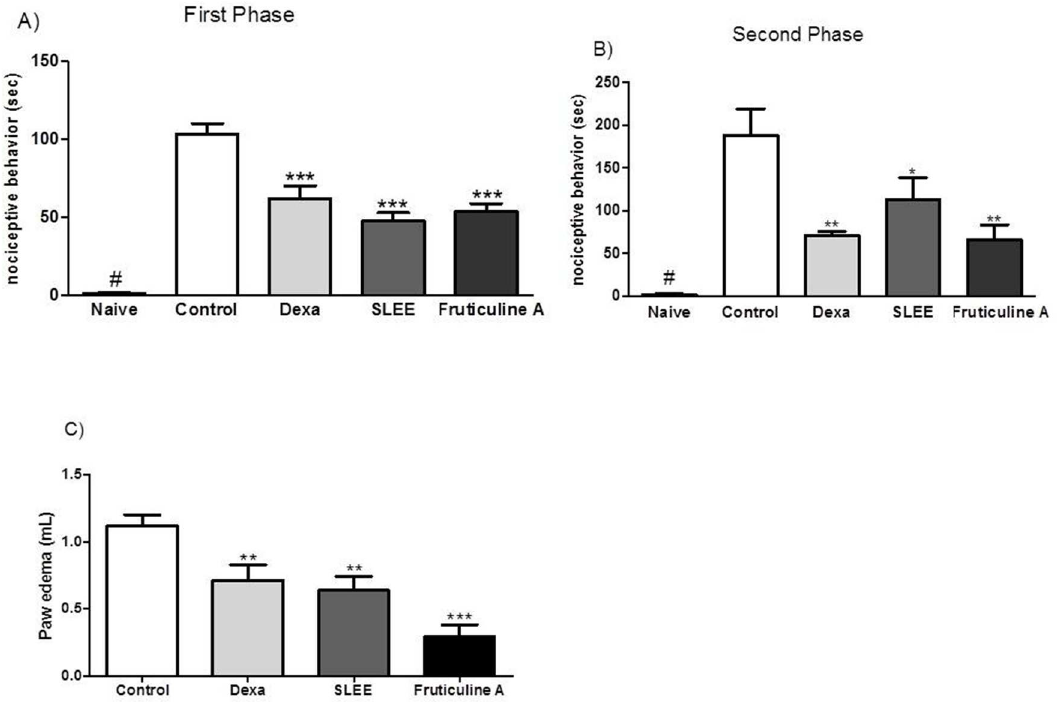
Fig 4. Effect of the oral administration of SLEE and fruticuline A on formalin-induced nociceptive behavior and the neurogenic edema test. In (A , B), the time that the animalsspent lickingor biting duringthe first phase(0–5 min) and the second phase(15–30min) is reported. In (C), neurogenicedemais presented. Bars indicateanimals that received control or naive (saline 0.9%), dexamethasone (1 mg/kg), SLEE (100 mg/kg, p.o.) or fruticulineA (3 mg/kg, p.o.). Bars express the mean ± SEM (n = 6) comparing the vehiclevs. treated groups ( * P < 0.05; ** P < 0.01and *** P <